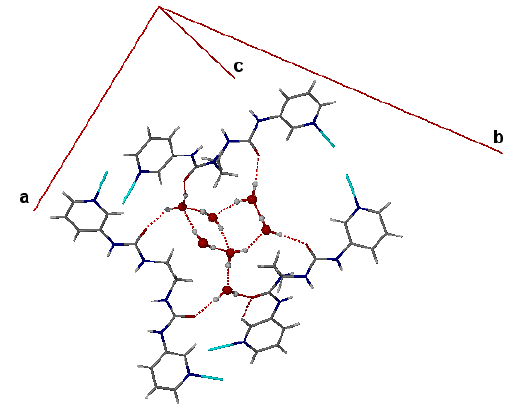
Figure 4. Discrete water heptamer in a Borromean structure